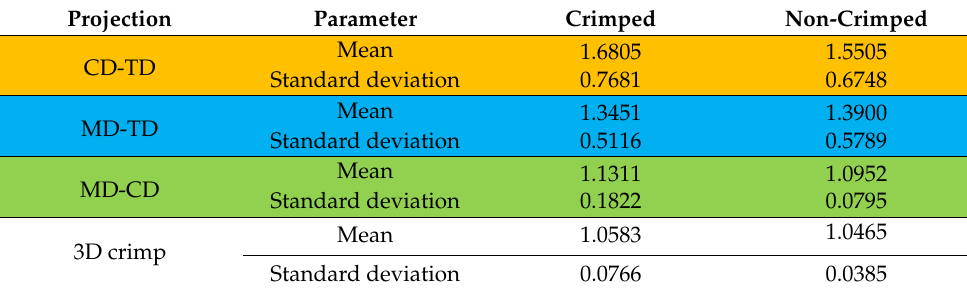
Table 4. Average statistical values of X-ray µ CT